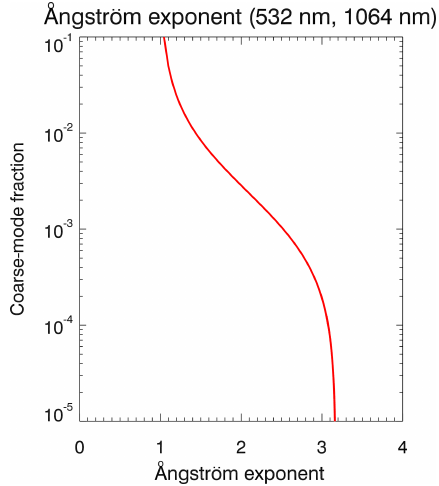
Figure 5. Shown is the dependence of the Ångström exponent α , which is determined from the simulated extinction cross sections, on the coarse-mode fraction of the assumed bimodal particle size